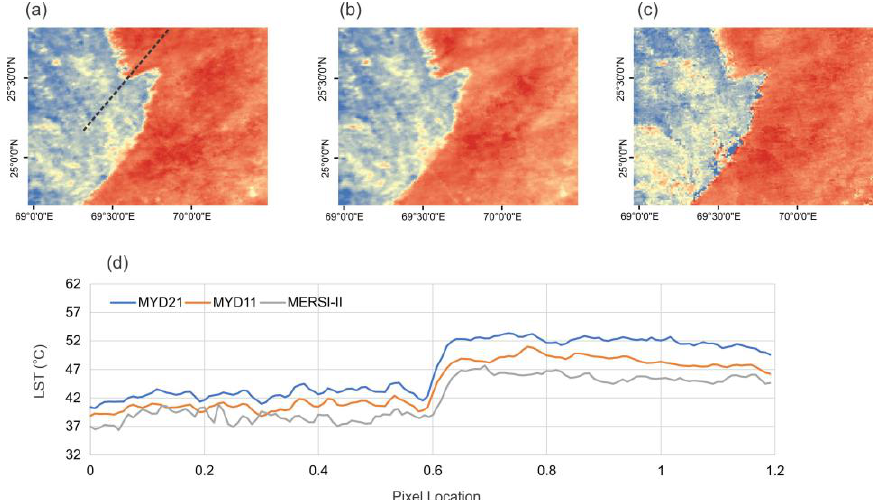
Figure 5. Spatial distribution of ( a ) MYD11A1, ( b ) MYD21A1, and ( c ) MERSI-II LST data. The dotted line represents the profile extraction location. ( d ) Latitudinal profile of three different LST data.